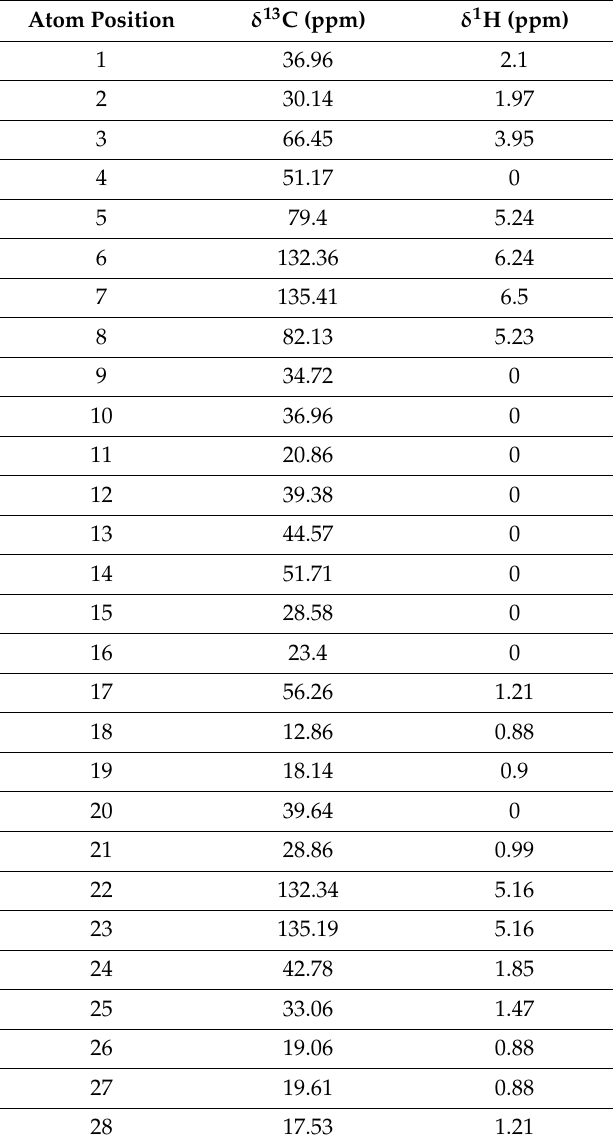
Table 1. 1 H and 13 C NMR spectral data for ergosterol